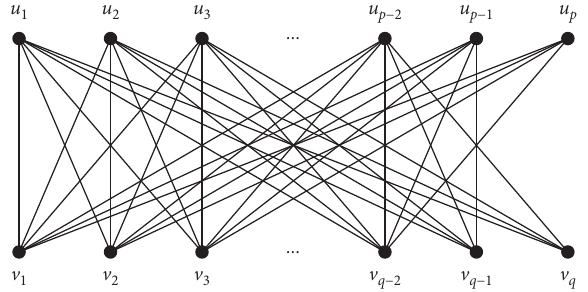
Figure 1: ( G 2 ) c � G 2 ( p,q ) c graph with m � pq − 3. n